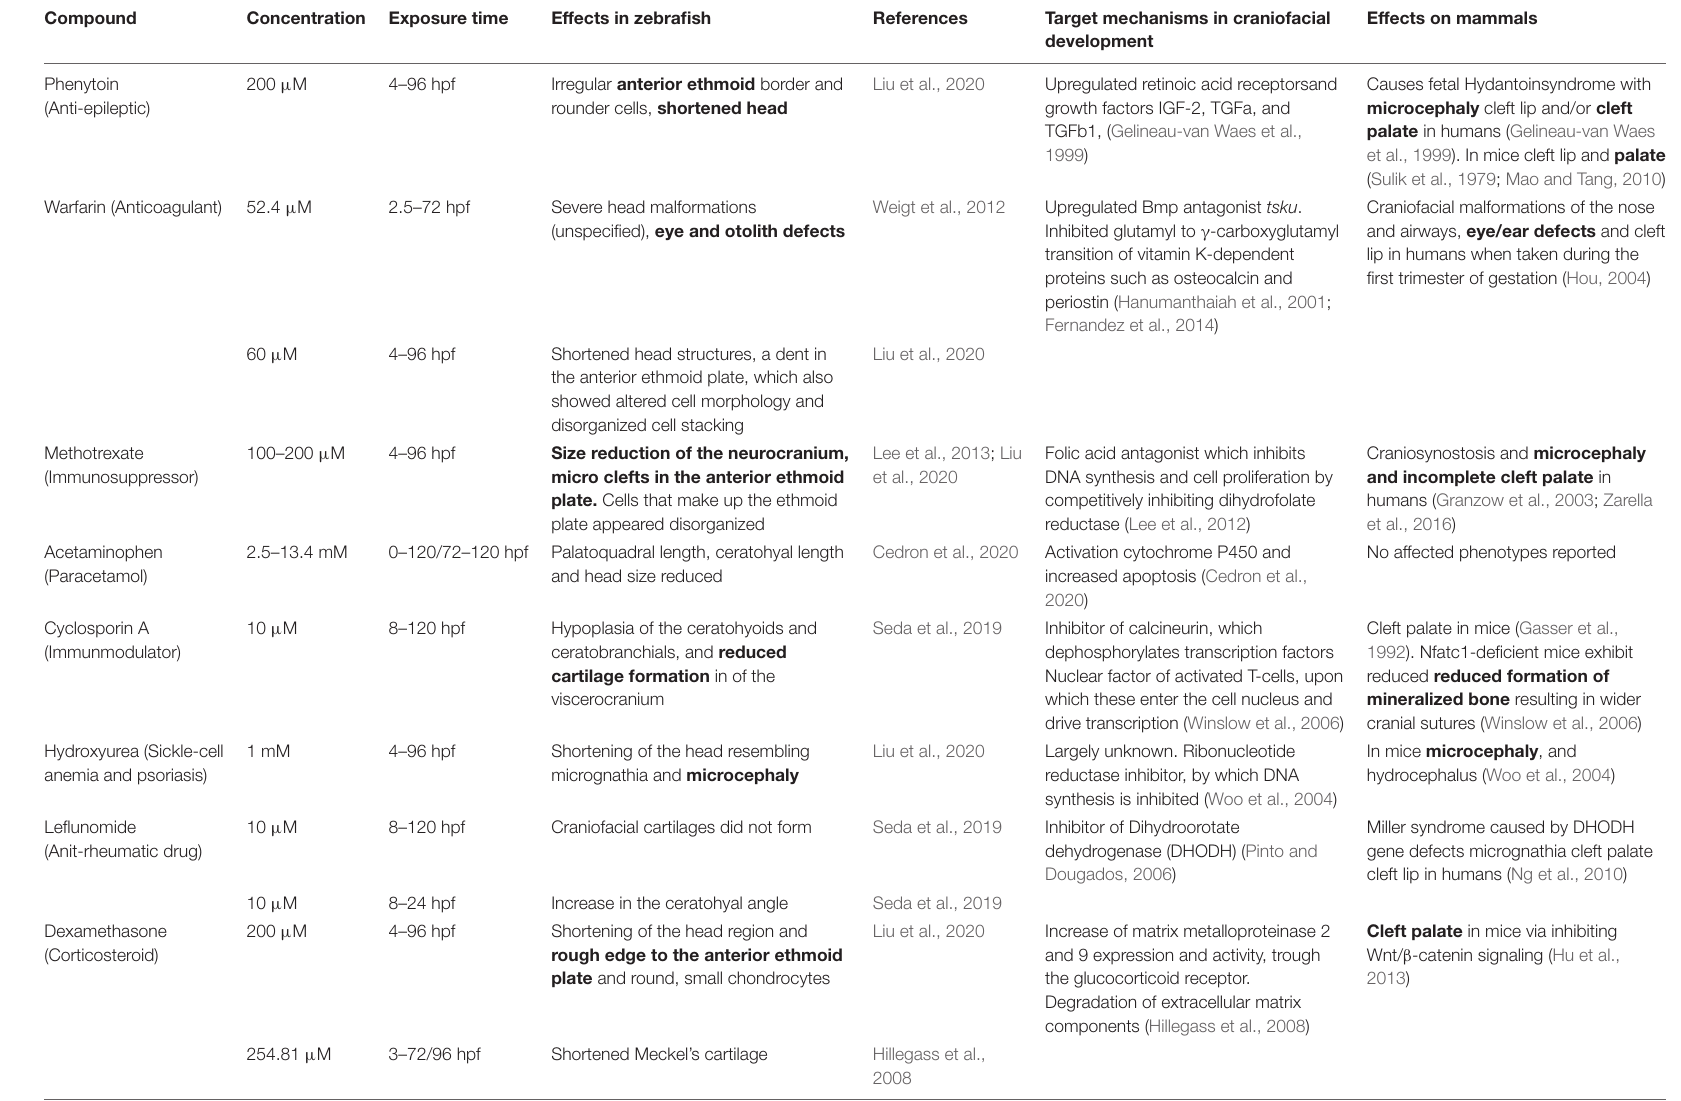
TABLE 1 | Reported effects of pharmaceuticals at various concentrations and exposure times on zebrafish craniofacial development and parallel craniofacial findings in humans or, if not available, in mice.